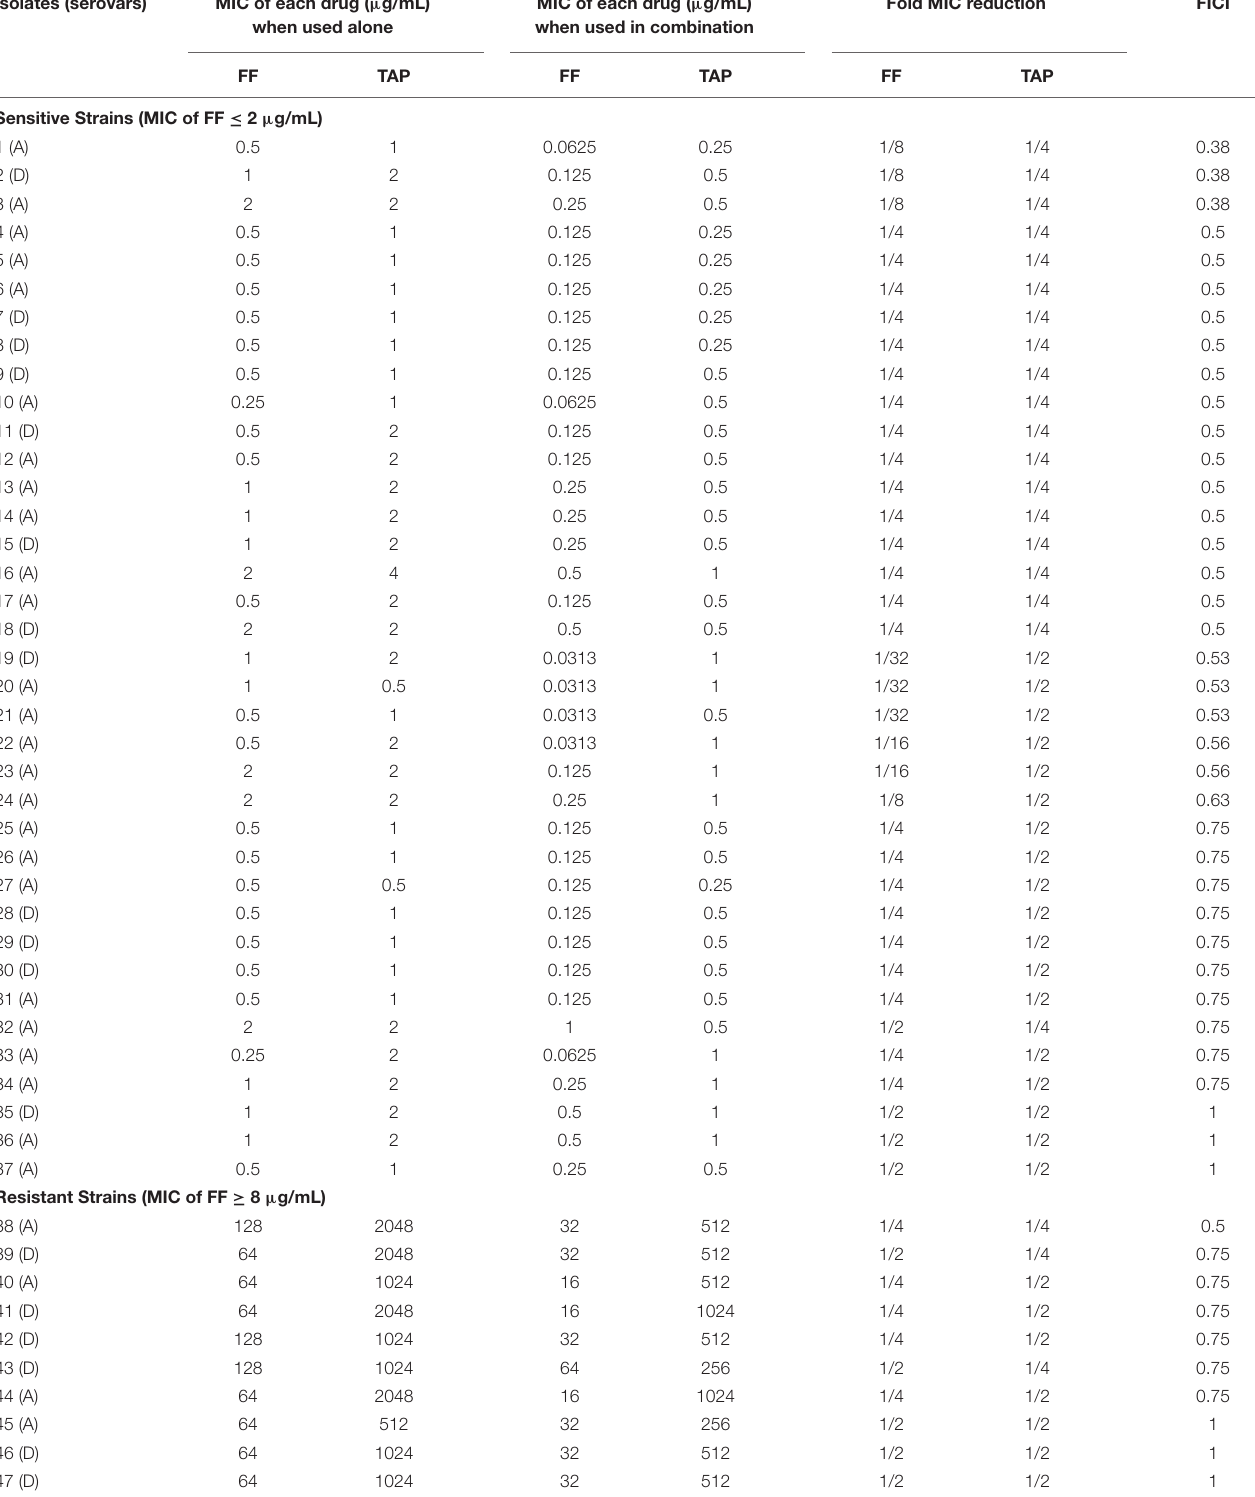
TABLE 3 | In vitro inhibitory activity of FF and TAP alone and in combination against P. multocida by checkerboard assay. Isolates (serovars) MIC of each drug ( µ g/mL) MIC of each drug ( µ g/mL) Fold MIC reduction when used alone when used in combination